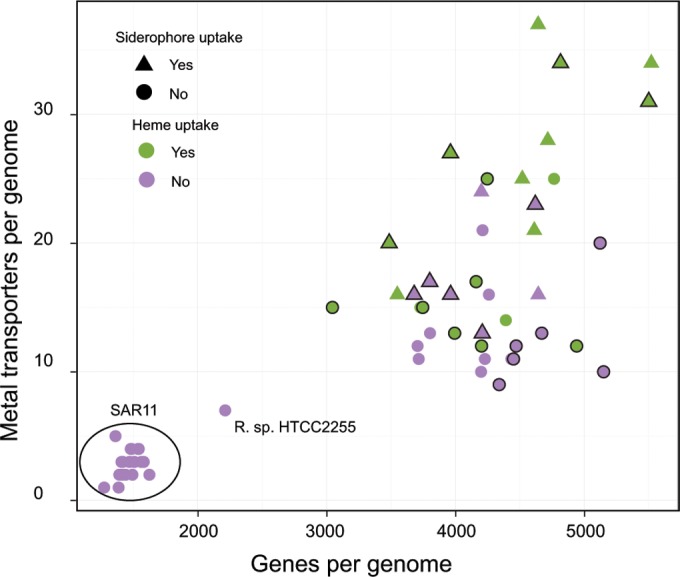
Scatter plot of metal transporters per genome plotted against genes per genome. Each point represents one genome and is colored according to the genomic potential for heme uptake and shaped according to the genomic potential for siderophore uptake. Points with a black outline represent organisms that have been experimentally confirmed to be particle associated or were isolated from an abiotic or biotic surface. The SAR11 genomes and the HTCC225 genome are the only genomes from organisms with confirmed planktonic lifestyles. Spearman's rank correlation coefficient (ρ) values were as follows: for SAR11 genomes (n = 22), ρ = 0.37 (P > 0.05); for Roseobacter genomes (n = 42), ρ= 0.31 (P < 0.05); for combined genomes (n = 64), ρ= 0.78 (P < 10−10).